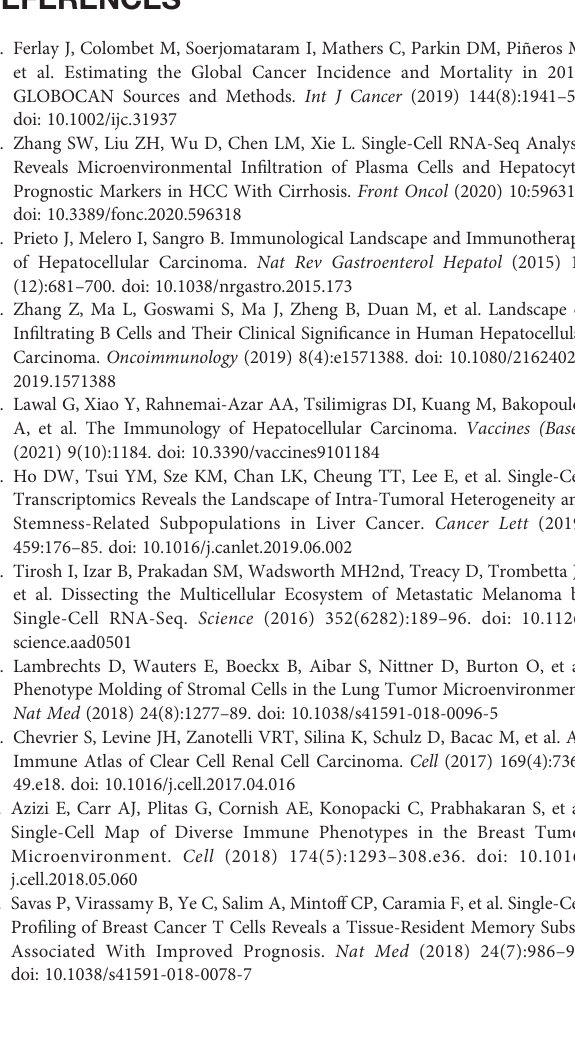
22,677 cells from HCC tissues (n = 10).